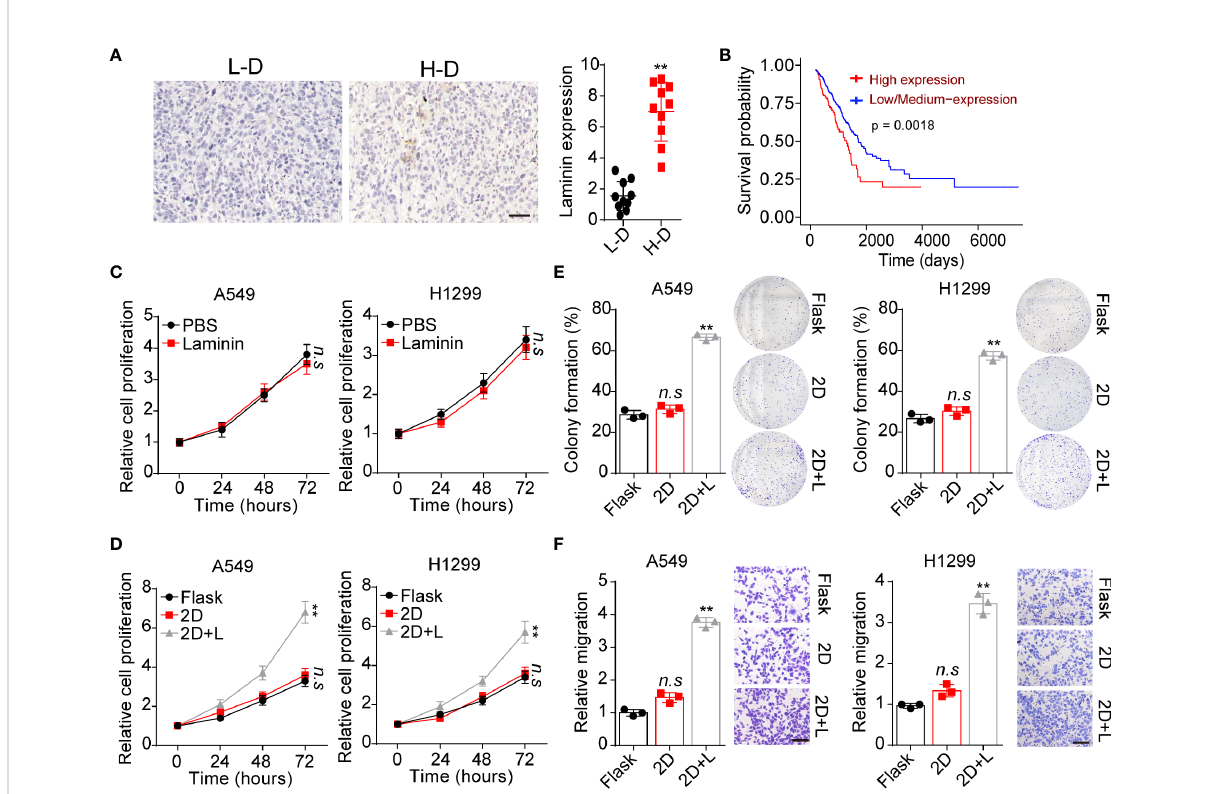
FIGURE 1 Laminin expression correlated with NSCLC progression. (A) , immunohistochemical staining of laminin in high degree (H-D) and low degree (L- D) tumor tissues from NSCLC patients. The scale bar is 50 m m. The intensity of laminin expression was calculated in each group (n=10). (B) , overall survival of NSCLC patients divided into laminin expression (n=126) and low/medium laminin expression (n=376) groups using TCGA database analysis. (C) , A549 and NCI-H1299 cells were treated with laminin (5 m g/ml) or PBS for 5 days. Then the proliferation of A549 and NCI- H1299 cells was evaluated using CCK-8 analysis. (D) , A549 and NCI-H1299 cells were cultured on fl ask, 2D collagen gels or 2D collagen gels containing laminin for 5 days. Then the proliferation of A549 and NCI-H1299 cells were evaluated using CCK-8 analysis. (E) , the colony formation analysis of A549 and NCI-H1299 cells in (D) . (F) , the relative migration cell numbers of A549 and NCI-H1299 cells in (D) using transwell analysis. The scale bar is 50 m m. **p < 0.01; n.s, no signi fi cant